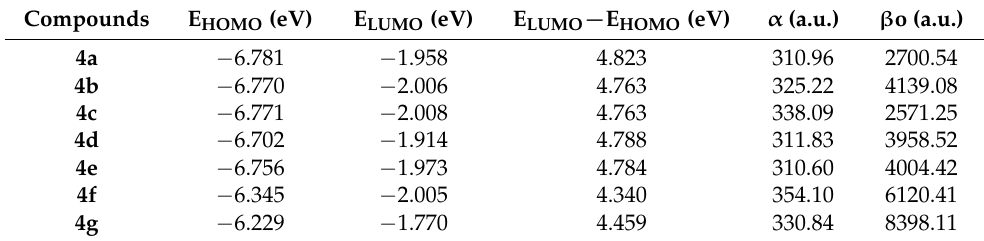
Table 2. Energies of the HOMO, LUMO, HOMO–LUMO energy gap, polarizability ( α ) and hyperpo- larizability ( β o) values of compounds 4a – 4n